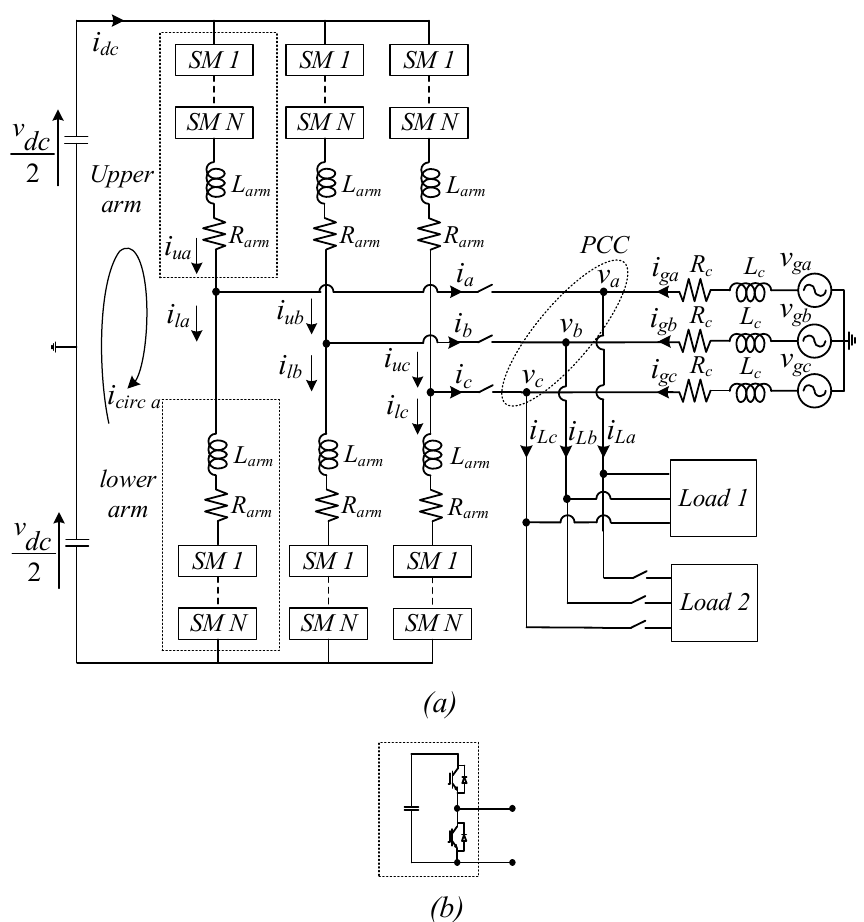
Figure 1. General schematic of a modular multilevel converter (MMC)-based static synchronous compensator (STATCOM): ( a ) Circuit structure; ( b ) Sub-module (SM) configuration.